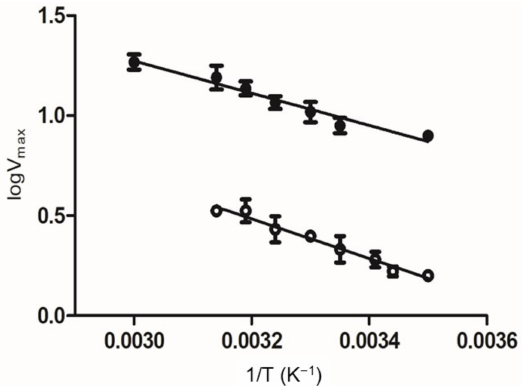
Figure 6. Effect of temperature on V max for the wild-type and the mutant Arg174Asn enzyme. The data were fitted to the Arrhenius equation for the wild-type, ( • ); and for the mutant (